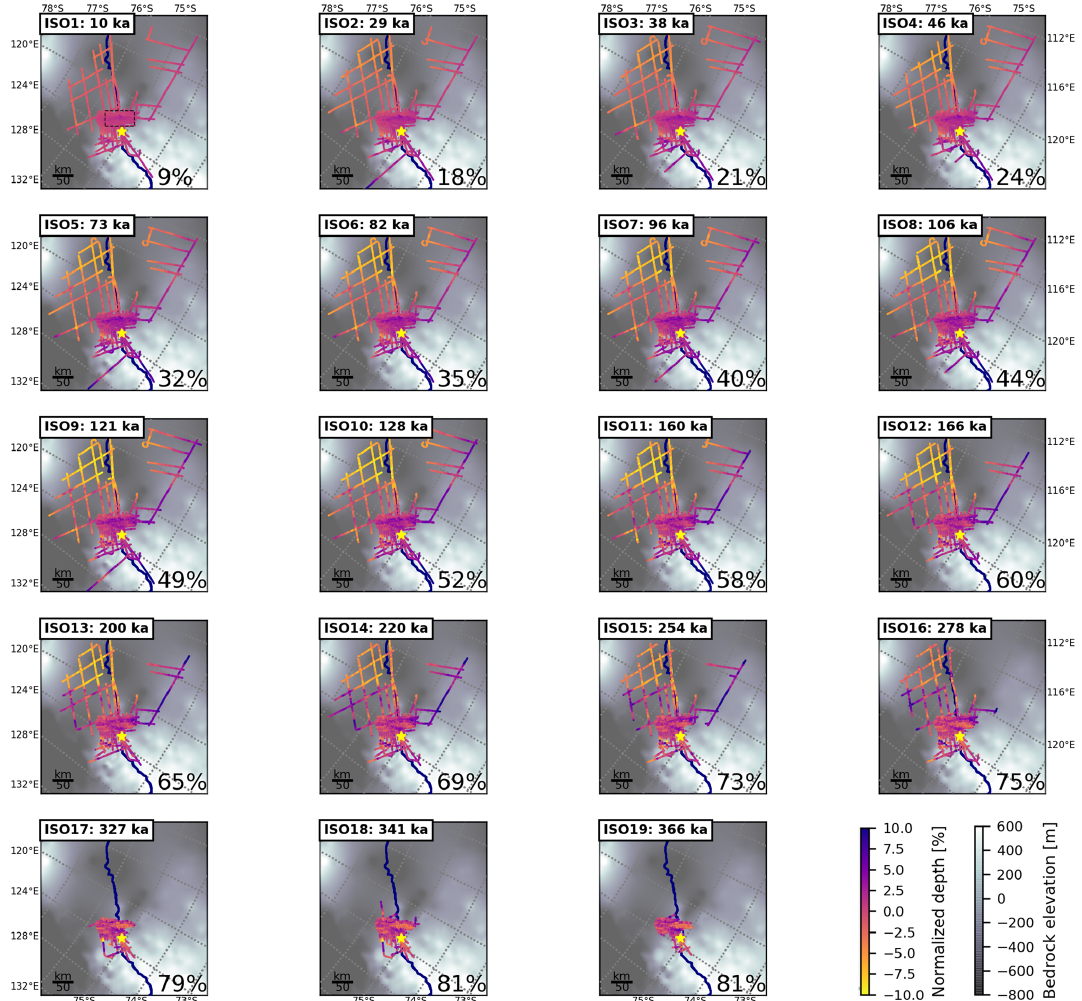
Figure 6. Spatial distribution of dated IRH depths over the Dome C region of the East Antarctic Plateau, overlain on BedMachine Antarctica v1 bedrock topography (Morlighem et al., 2020) for context. The color scale represents the percent depth anomaly of the IRH from its average percent depth (marked in the bottom right corner of each panel): darker colors imply that the IRH is deeper locally than on average, and lighter colors imply that the IRH is shallower locally than on average. Percent depths are normalized by the ice thickness, both measured from the radar returns (HiCARS, MCoRDS or DELORES). The yellow star locates the EDC ice core site, and the navy blue line outlines the position of the ice divide (Zwally et al., 2012). A black dashed box on the first panel outlines the LDC highland area covered by Figs. 7 and